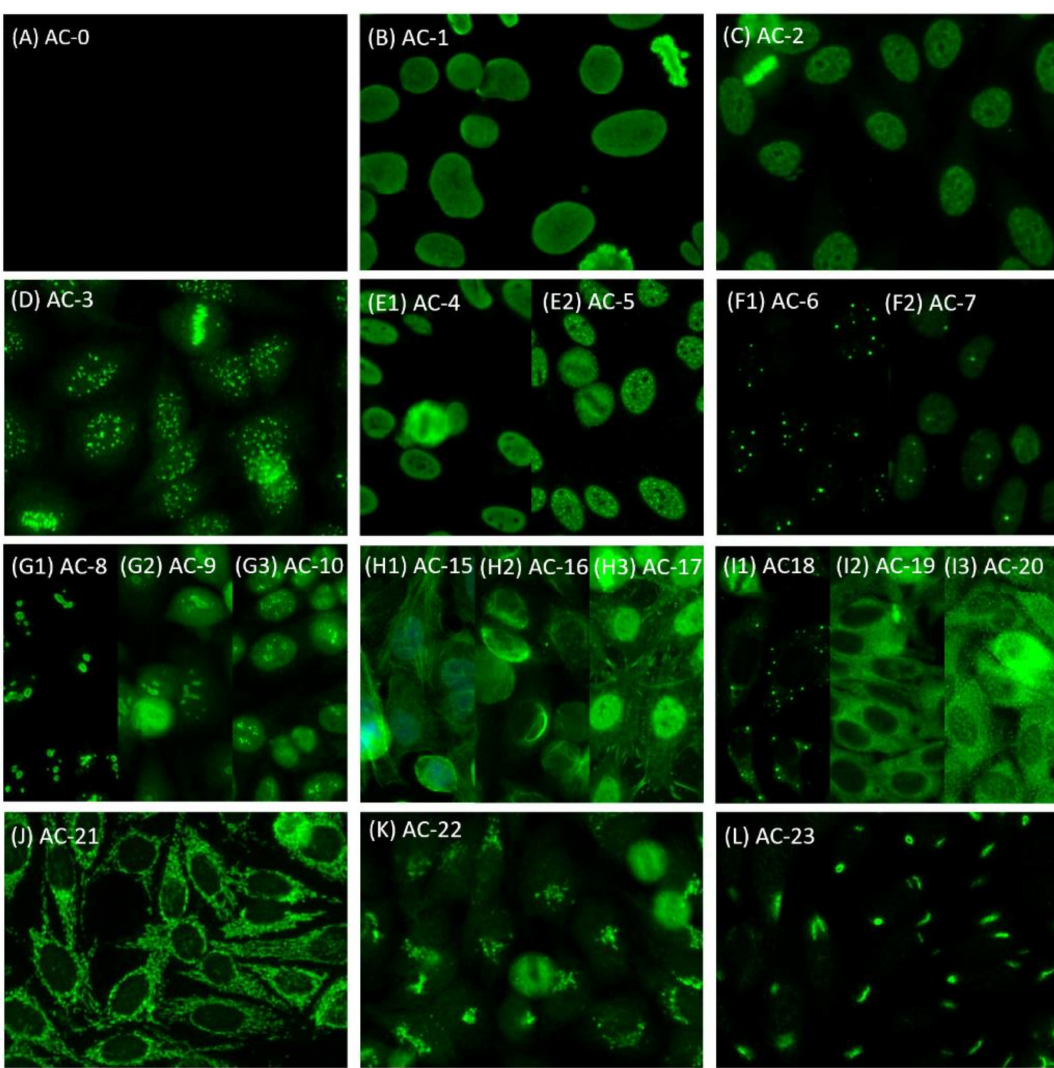
Figure 1. Representative images (INOVA, San Diego, USA) of human epithelial (HEp-2) cell patterns according to Inter- national Consensus on Antinuclear Antibody Patterns (ICAP) classification. ( A ) negative; ( B ) nuclear homogenous; ( C ) nuclear dense fine speckled; ( D ) nuclear centromere; ( E1 ) nuclear fine speckled; ( E2 ) nuclear large/coarse speckled; ( F1 ) multiple nuclear dots; ( F2 ) few nuclear dots; ( G1 ) homogenous nucleolar; ( G2 ) clumpy nucleolar; ( G3 ) punctate nucleolar; ( H1 ) fibrillar linear; ( H2 ) fibrillar filamentous; ( H3 ) fibrillar segmental; ( I1 ) cytoplasmic discrete dots; ( I2 ) cytoplasmic dense fine speckled; ( I3 ) cytoplasmic fine speckled; ( J ) cytoplasmic reticular/mitochondrion-like (AMA); ( K ) cytoplasmic Golgi; ( L ) cytoplasmic rods and